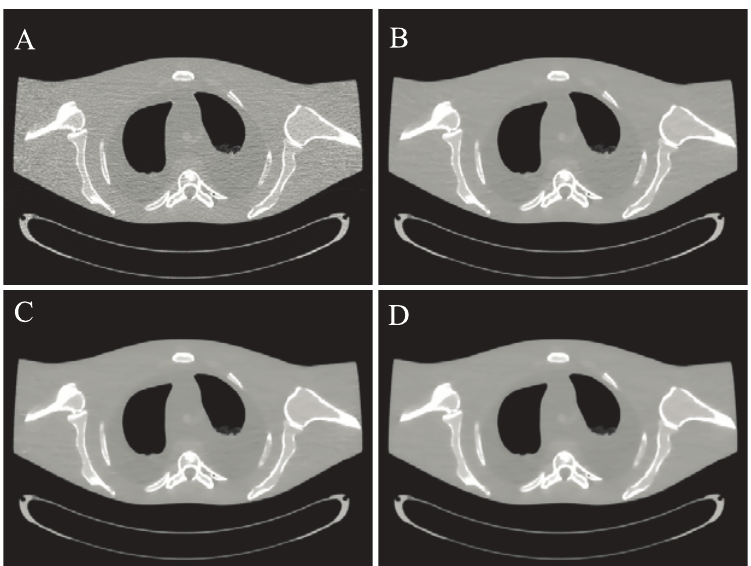
Fig 6. The anthropomorphic torso phantom scanned with a protocol of 40 mAs and 120 kVp. (A) is the result from the FBP algorithm with ramp filter; (B) is the result from the NCG algorithm with β = 1.0 × 10 5 ; (C) is the result from the SB-NCG algorithm with γ = 2 5 , β = 2 9 ; and (D) is the result from the ALM-ANAD algorithm with γ = 2 5 , β = 2 9 . The zoomed ROIs indicated by the rectangle are also displayed for visual appealing. All images are displayed with the same window [0.0017 0.024] mm − 1 .